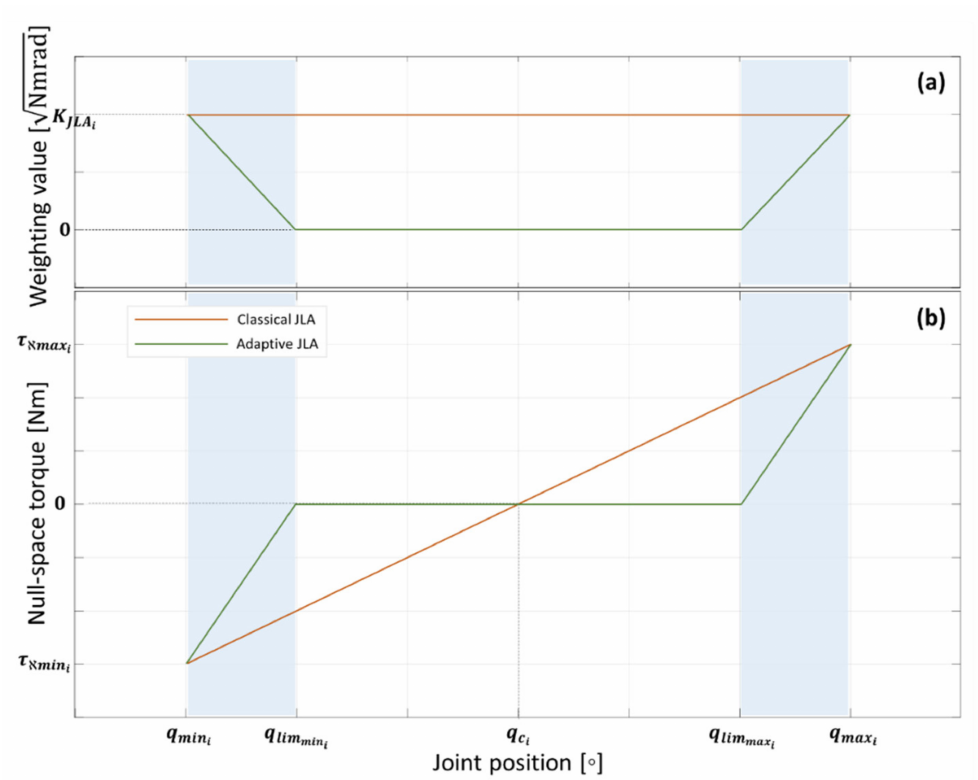
Figure 15. Evolution of ( a ) the weighting value and ( b ) the null-space torque for classical and adaptive JLA strategies along the position range of joint i